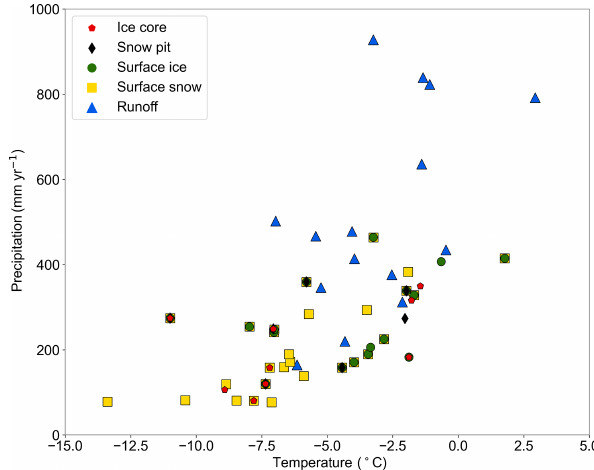
Figure 2. Multiyear average air temperature and precipitation of sampled glaciers.